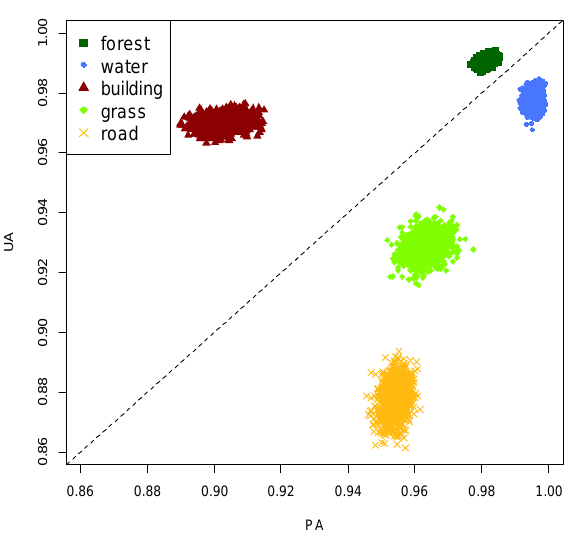
Figure 7. Relation between user’s accuracy and producer’s accuracy with five